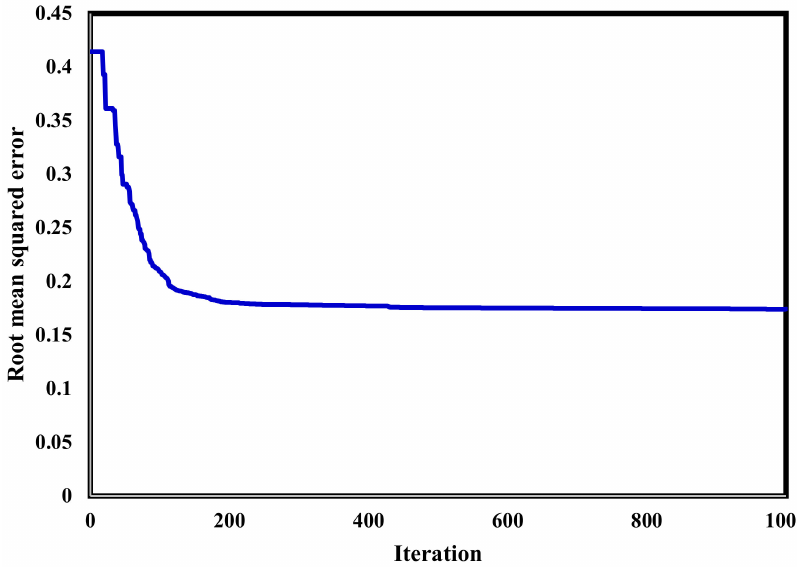
Figure 4. ANFIS performance during the training stage using the particle swarm optimization (PSO) approach (with ten